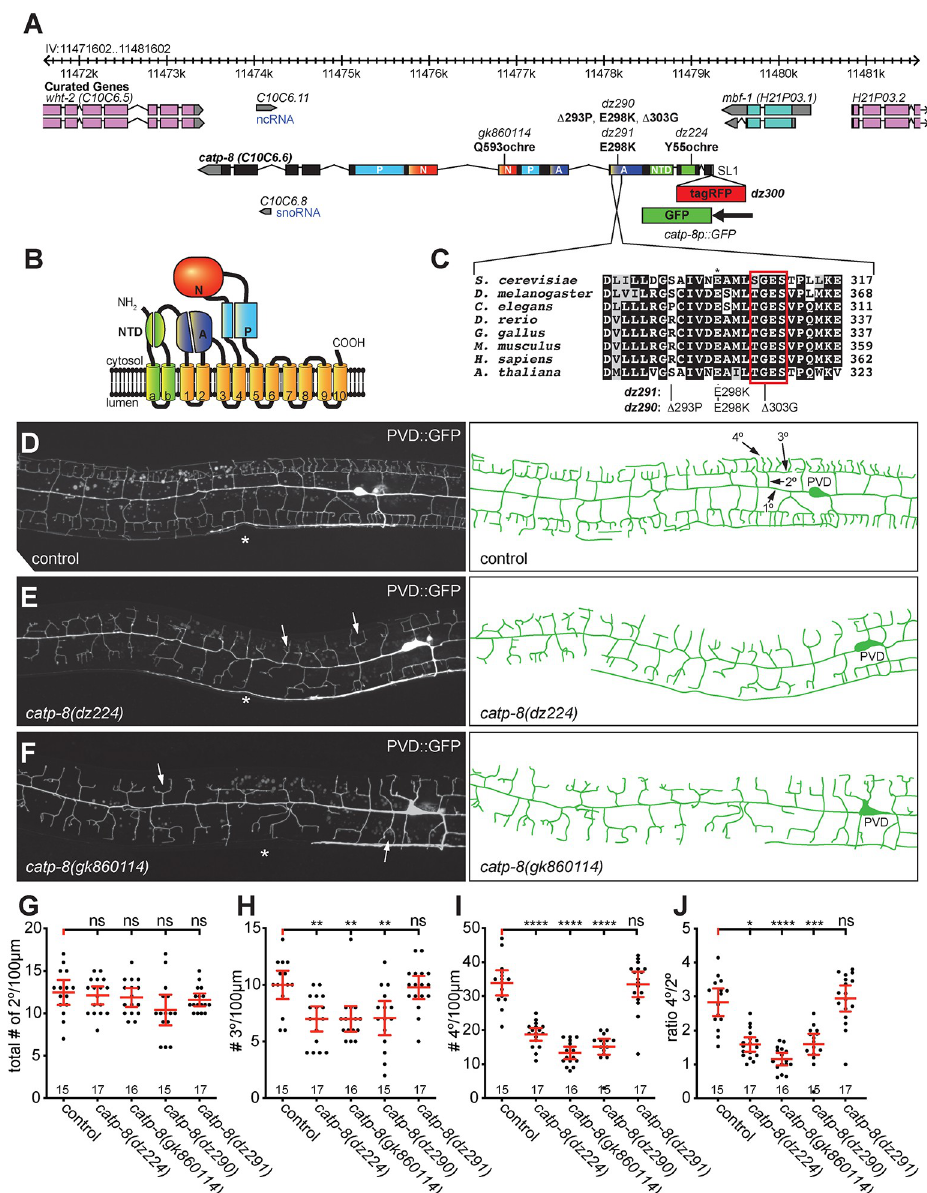
Fig 1. CATP-8/P5A-ATPase is required for PVD dendrite patterning. A. Genetic environs of the catp-8 locus on chromosome IV. catp-8 is encoded on the minus strand and transcribed from right to left. Alleles used in this study are indicated as are the resulting molecular changes. The catp-8 transcript can be SL1 spliced based on the yk1435b05 EST clone (gift of Y. Kohara). Since catp-8 has also been suggested to be SL2 spliced [23], catp-8 may be part of a hybrid operon. Parts of the exons that encode specific domains are color coded and designated as: NTD: N-terminal domain, A: actuator domain, N: nucleotide binding domain, P: phosphorylation domain. A schematic of the catp-8p :: GFP transcriptional reporter is shown as is the genomic location of the tagRFP insertion to create the translational tagRFP:: CATP-8 reporter. B. Schematic domain structure and membrane topology of the CATP-8/P5A ATPase with the domains labeled and color coded as in A. C. Alignment of a conserved section of the actuator domain encoding a phosphatase activity, which is required for functional cycling of P-type ATPases [15]. The E298K mutation (asterisk, equivalent to the E349K mutant associated with intellectual disability [32]) is immediately adjacent to the (S/T)GES loop (boxed in red), which is important for A-domain function [25]. Noted on the right is the number of amino acids. Accession numbers of sequences for P5A-type ATPases used in the alignment are P39986 ( S . cerevisiae ), Q9VKJ6 ( D . melanogaster ), P90747 ( C . elegans ), F1R1X4 ( D . rerio ), Q5ZKB7 ( G . gallus ), Q9EPE9 ( M . musculus ), Q9VKJ6 ( H . sapiens ), Q9LT02 ( A . thaliana ). D. -F. Fluorescent micrographs of PVD neurons with corresponding schematics on the right in the genotypes indicated. PVD was visualized with wdIs52 ( Is[F49H12 . 4p :: GFP] )[28]. Asterisks mark the